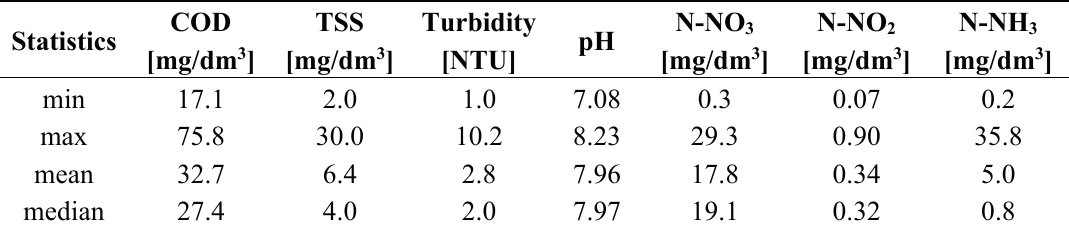
Table 4. The range and average values of wastewater quality standard parameters measured during normal SBR performance, for which e-nose measurements were also